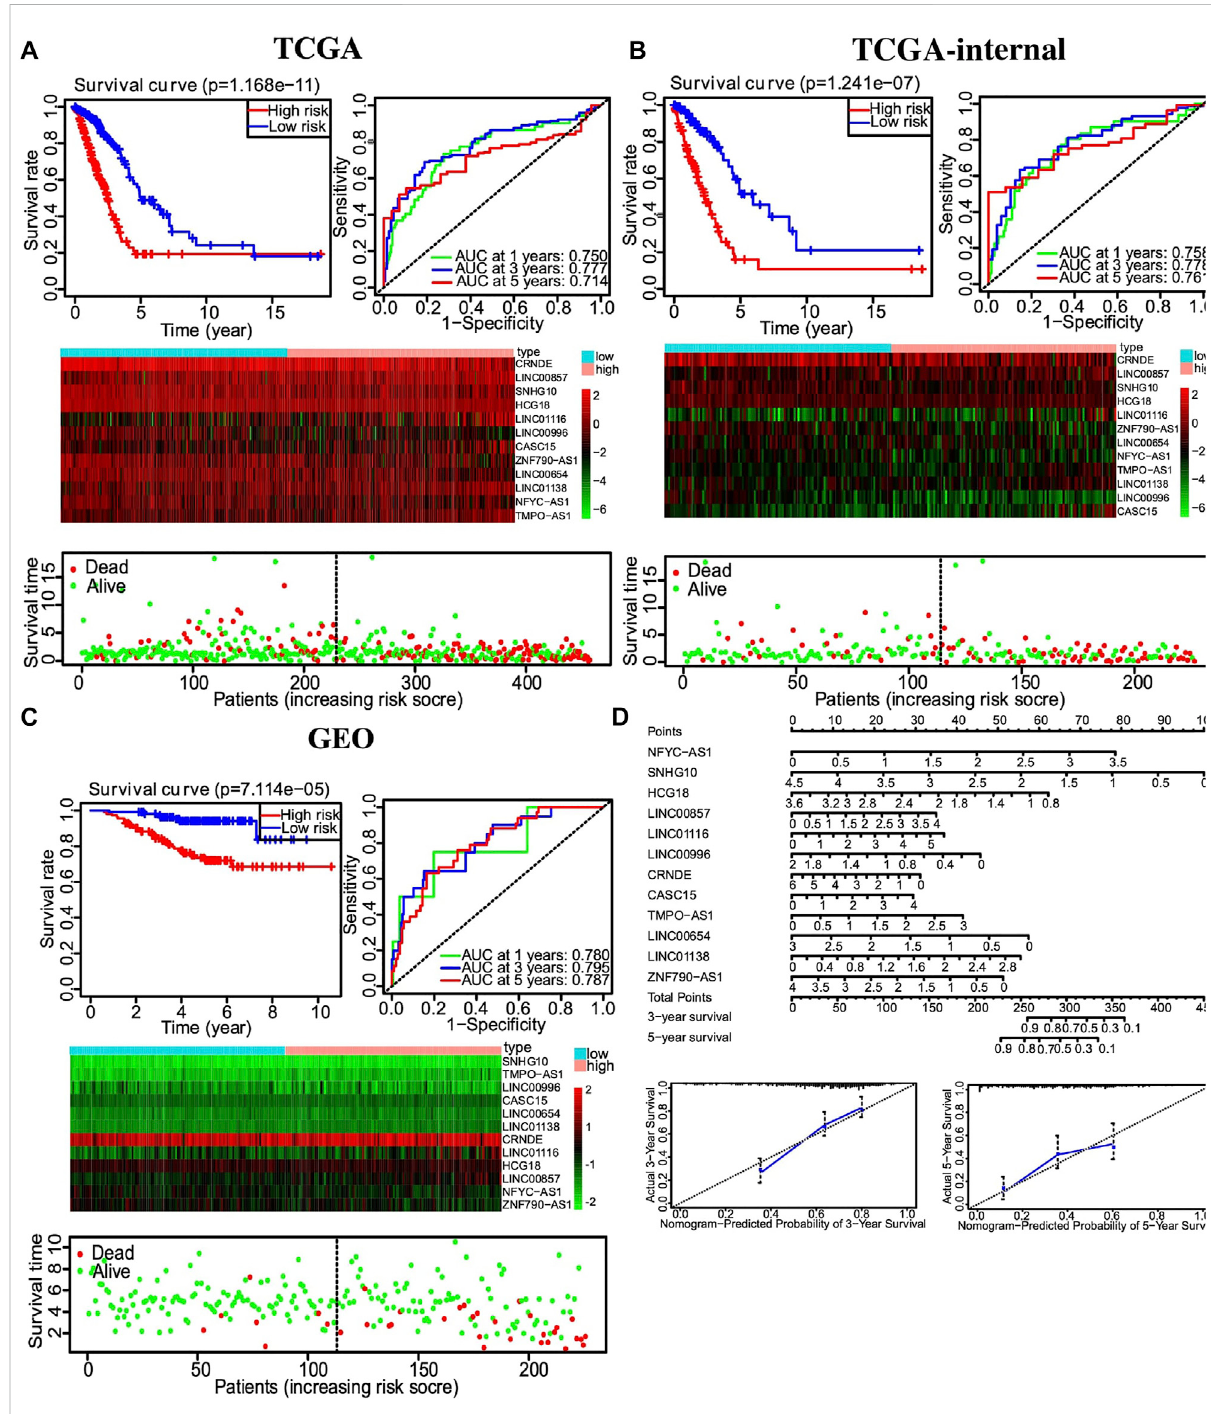
FIGURE 6 Autophagy-related lncRNA risk score analysis of LUAD patients. (A) Top left, Kaplan – Meier survival analysis of the high- and low-risk groups based on the median risk score. Top right, 1-, 3-, and 5-year AUC value of ROC analysis. Middle, heatmap of autophagy-related lncRNAs expression pro fi les in thelow- and high-risk groups. Bottom, the scatterplot based on the survival status of each patient. (B) Similar results to 6A from the TCGA train dataset. (C) Similar results to 6A from the GSE validation dataset. (D) Nomogram of 12-lncRNA signature based on multivariate Cox proportional hazards regression